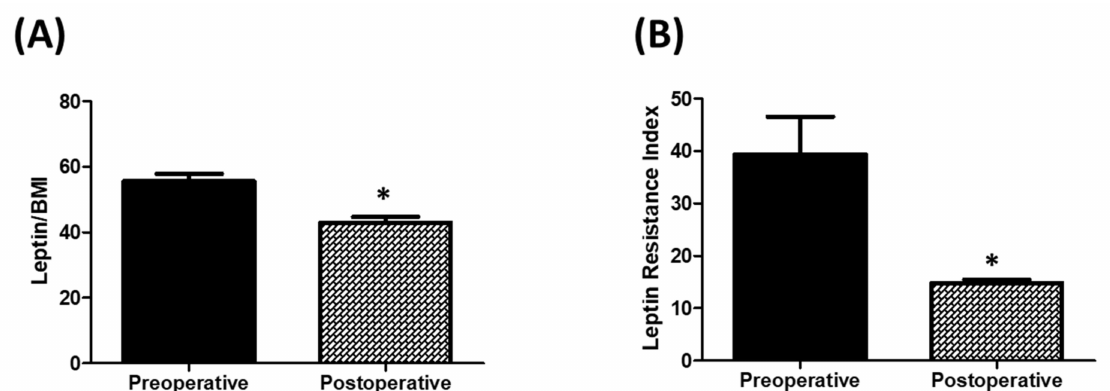
leptin receptor levels. * p < 0.05 vs. preoperative value; CI: 861.4–1264.8. ( B ) Comparison between obese patients preoperatively and 1-year postoperatively in leptin resistance index. * p < 0.05